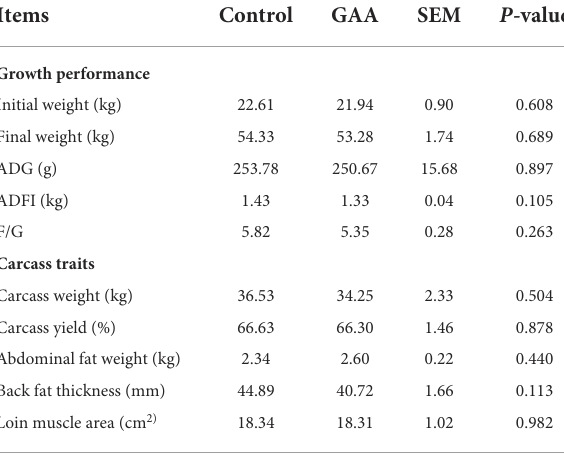
TABLE 2 Effect of dietary GAA on meat quality of Longissimus thoracis in Tibetan pigs.